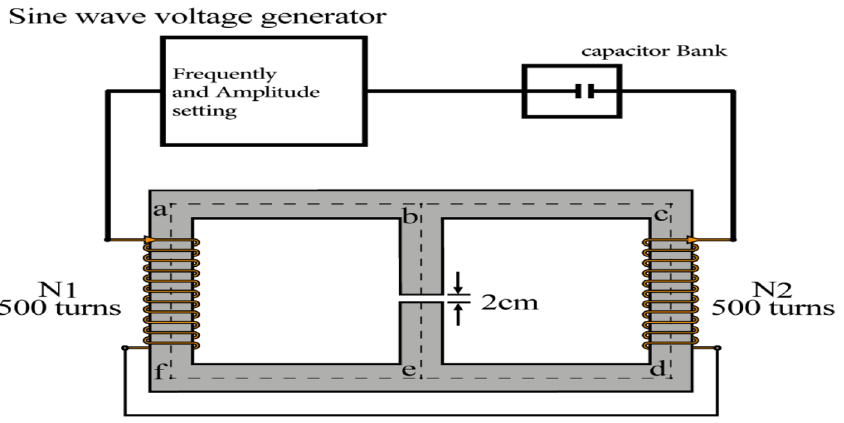
Figure 1. Schematic of the magnetic circuit producing the magnetic field in the air